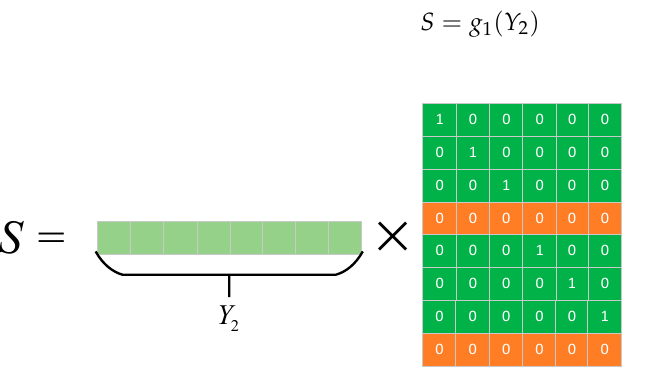
Figure 9. Matrix multiplication to realize equal interval cutting of data.